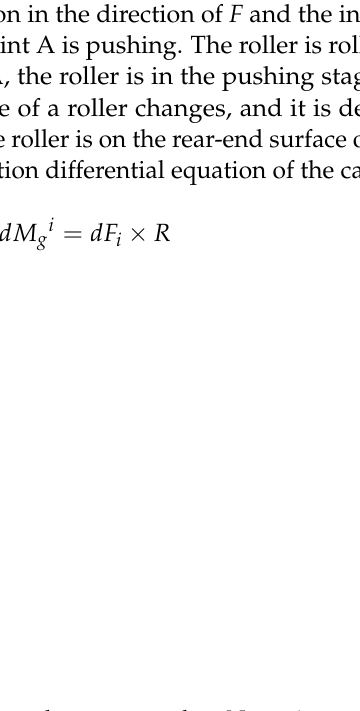
Figure 9. Three states of the main roller and cam curve slot. Note: 1—cam curve slot, 2—main roller, 3—rear-end surface, and 4—front-end surface. A—The critical point A, B—The critical point B, C—The critical point C.